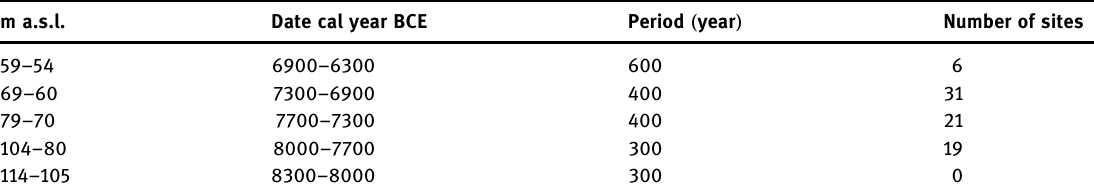
Table 5: Distribution of sites per height/period in the Middle Mesolithic in the northern Vestfold County ( Horten, Holmestrand, Tønsberg, and Sandefjord Municipalities ) . Site data are collected from the national database of archaeological sites ( Askeladden, 2021 ) . Periods are estimated based on the RSL curve ( cf. above